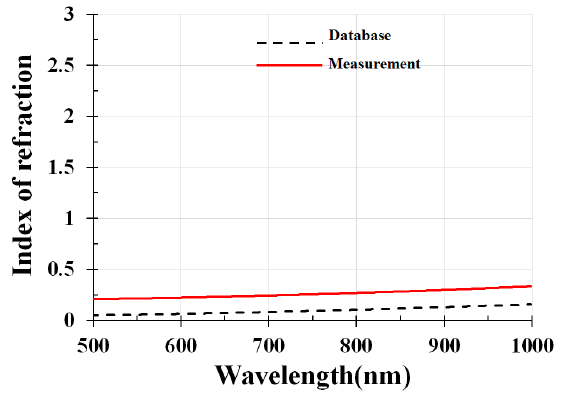
Figure A1. The indexes of refraction of Ag versus wavelength from measurement and database.